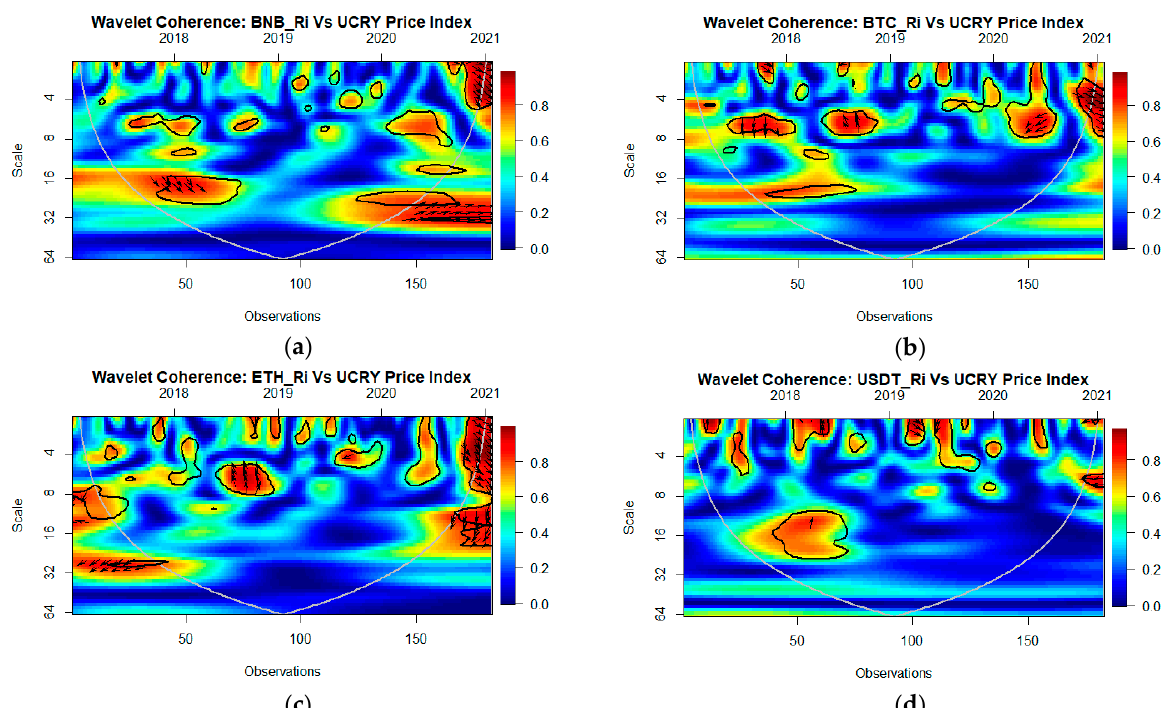
Figure 3. Wavelet coherence between conventional cryptos and UCRY price index. Note: ( a ) = wavelet coherence between Binance Coin and UCYR Price Index, ( b ) = wavelet coherence between Bitcoin and UCYR Price Index, ( c ) = wavelet coherence between Ethereum and UCYR Price Index, ( d ) = wavelet coherence between Tether and UCYR Price Index.